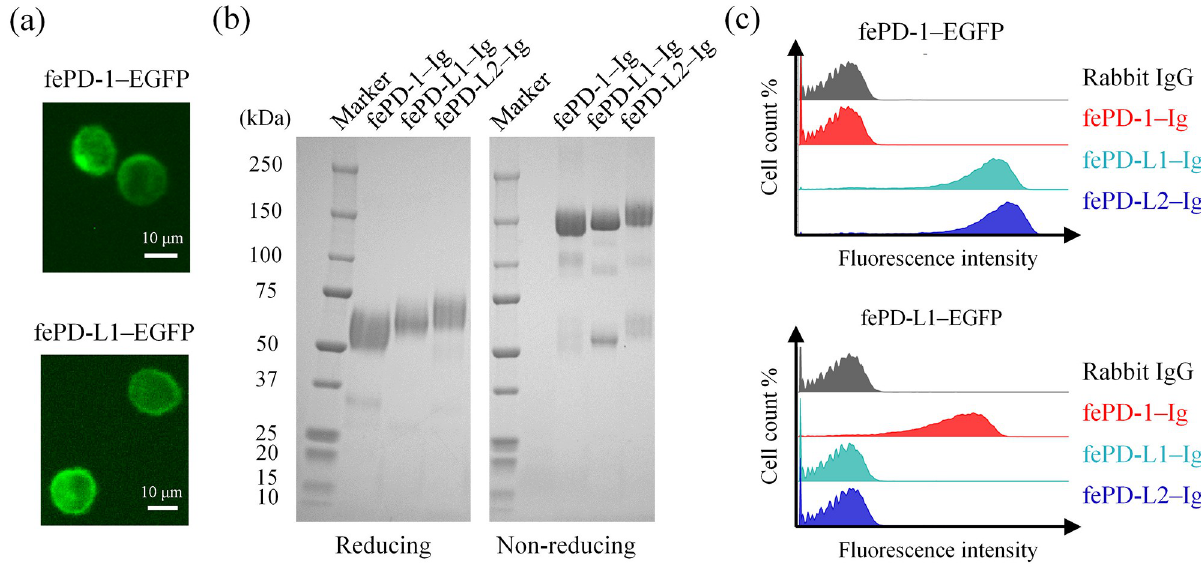
Fig 3. Characterization of feline PD-1/PD-L1/PD-L2 proteins. (a) Preparation of fePD-1–EGFP- and fePD-L1–EGFP-expressing cells. Cells were harvested and observed under a fluorescent microscope at 24 h post transfection. (b) Preparation of fePD-1–Ig, fePD-L1–Ig, and fePD-L2–Ig. The purified Fc-fusion proteins were separated under reducing (left) or non-reducing (right) conditions by SDS-PAGE. The proteins were visualized by CBB staining. (c) Binding of Fc-fusion proteins to fePD-1–EGFP- and fePD-L1–EGFP-expressing cells. Cells were incubated with 10 μ g/mL of each Fc- fusion protein and their binding was detected using anti-rabbit IgG secondary antibody. Rabbit IgG was used as a negative control.